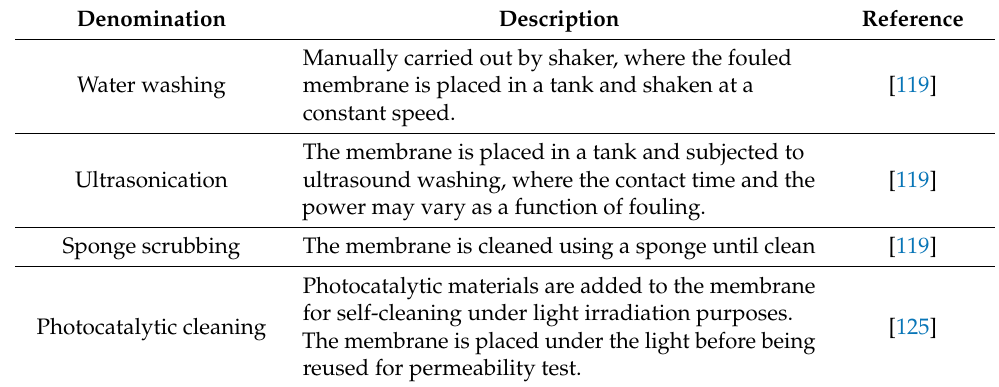
Figure 3. Illustration of membrane fouling types, mechanisms and the required cleaning techniques [124]. Table 4. Different cleaning strategies [115,123].